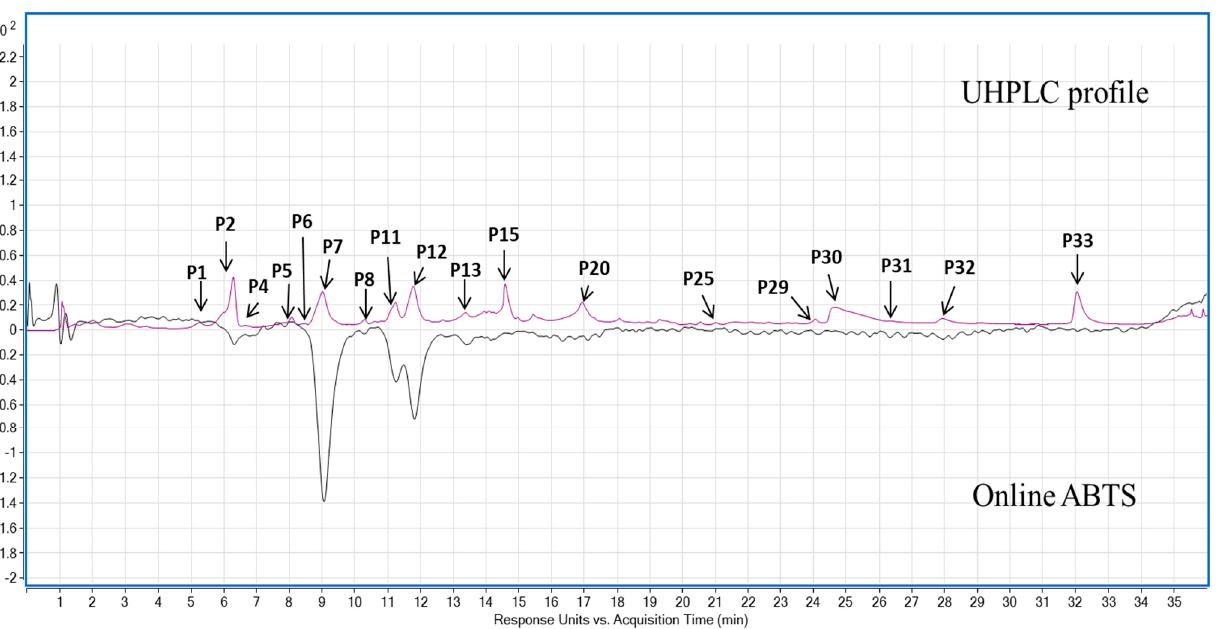
Data are the means ± SD ( n = 3). Different alphabets in each row indicated a significant difference in antioxidant activity. – not detected. TE: Trolox equivalent.